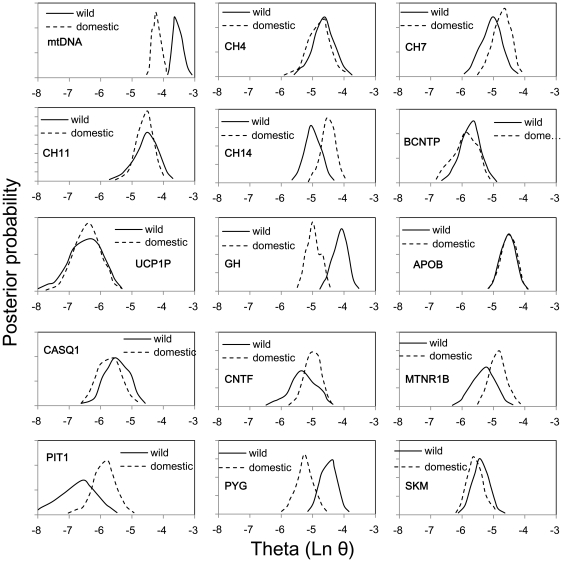
Comparison of θ in D-loop and 14 nuclear markers between wild boars and domestic pigs.The values of θ (4Neμ for autosomal markers and 2Nfμ for mtDNA, Nf = effective population size of females and μ = mutation rate) were calculated by using Lamarc analysis.